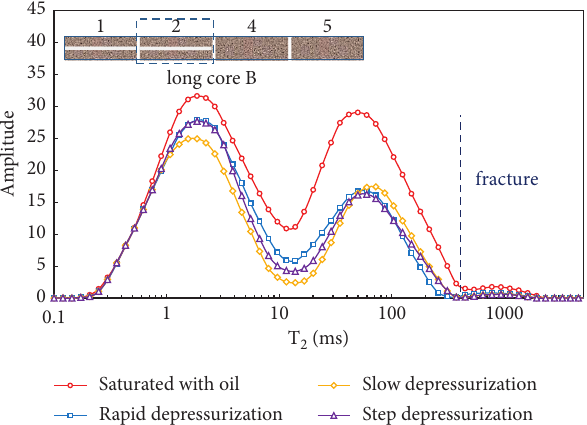
Figure 16: The microscopic remaining oil distribution of fractured core #2 after huff-and-puff tests with different depressurization